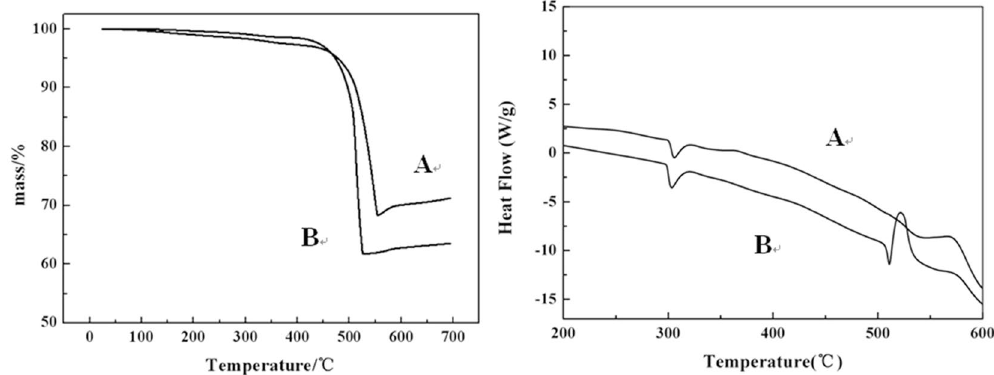
Figure 9. TG-DSC curve of the samples at heating rate of 10 °C. min − 1 in air atmosphere ( A ) MM Kp and Al/ CuO ( B ) Kp@Al/CuO